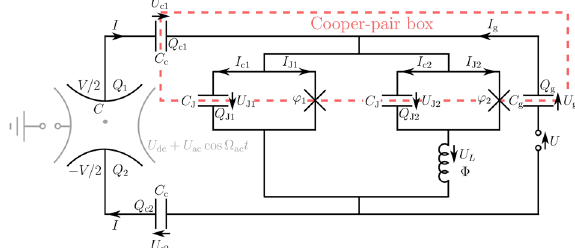
Fig. 4 Circuit diagram. The tunable Cooper-pair box is coupled to the particle via the trap capacitor. The dashed line indicates the superconducting island from which Cooper pairs can tunnel onto the endcap electrode. The arrows indicate the direction of increasing electrostatic potential for positive U ’ s and of the electron fl ow for positive I ’